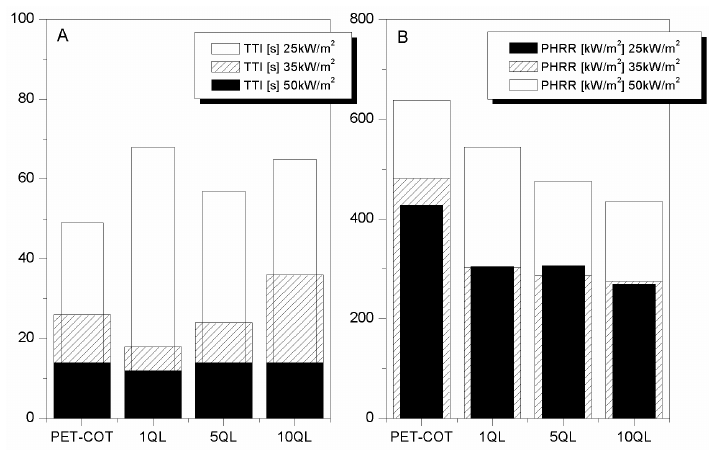
Figure 12. TTI ( A ) and PHRR ( B ) values of PET-COT fabrics treated with 1, 5 and 10 QL at 25, 35, and 50 kW/m 2 [29].